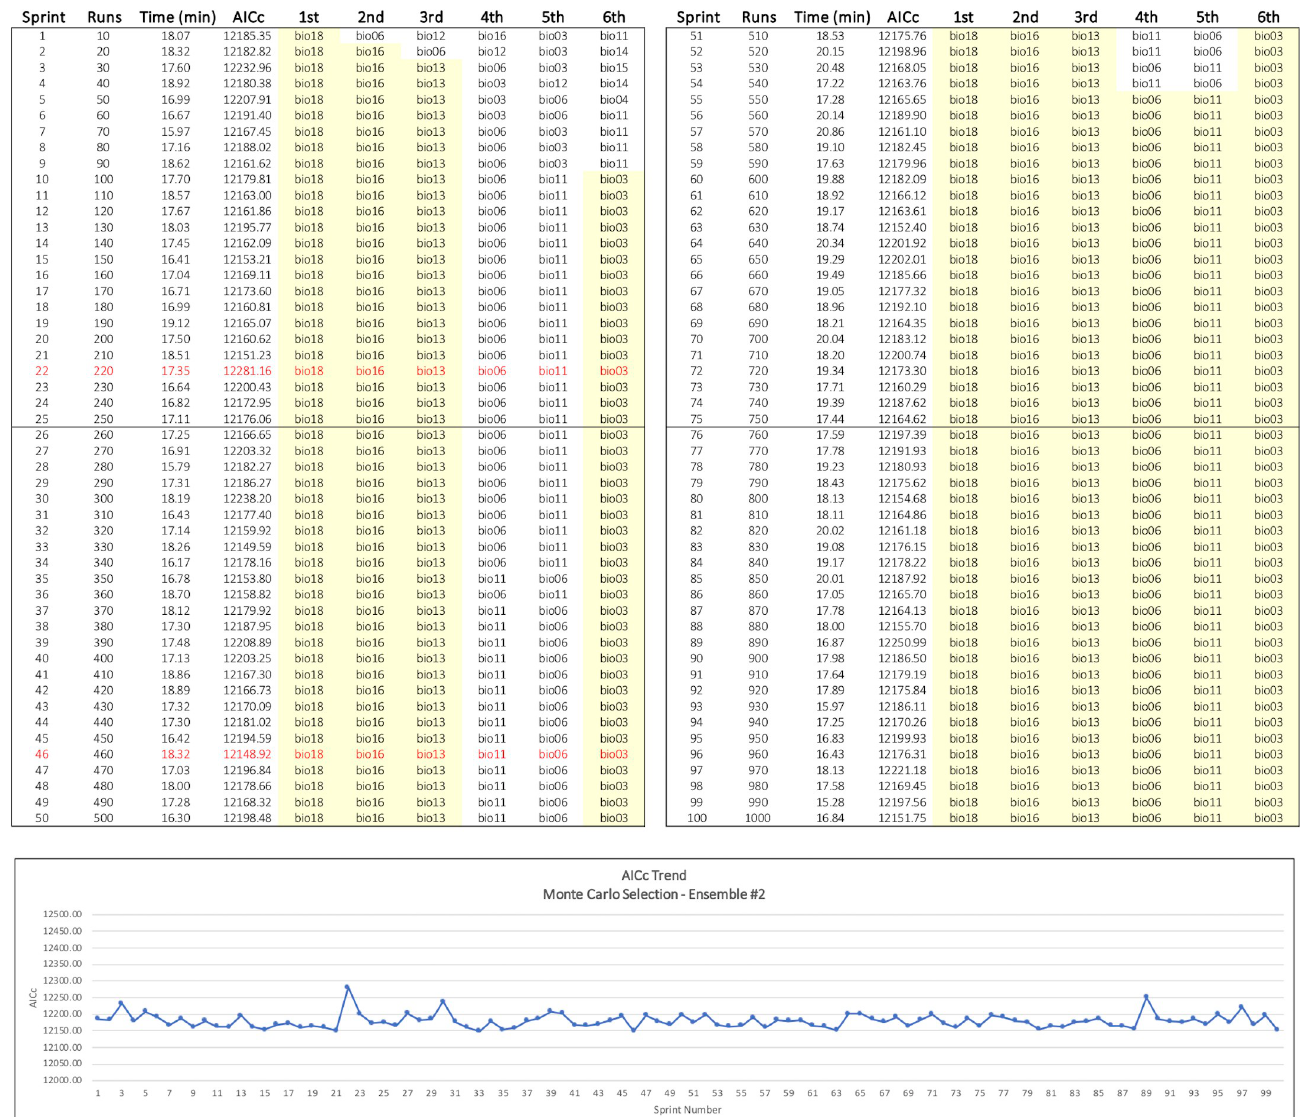
Fig 3. Monte Carlo Ensemble #2 results. Six random variables at a time were chosen for each MaxEnt sprint run. The sprint log on top shows the progressive selection of a stable set of top six variables in yellow. The graph on the bottom shows the narrow range of fluctuating AICc values over the course of the ensemble runs. Maximum and minimum AICc values are shown in